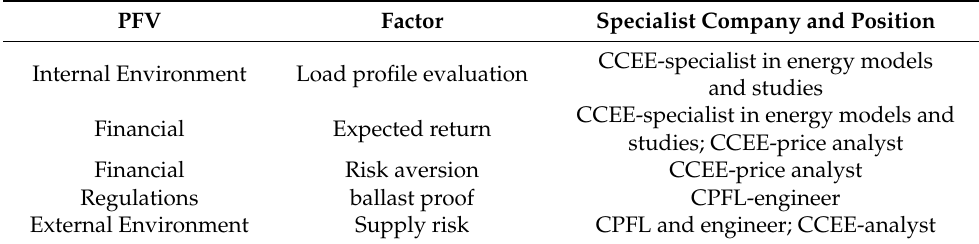
Table 4. Factors pointed out by experts in the Brazilian electricity